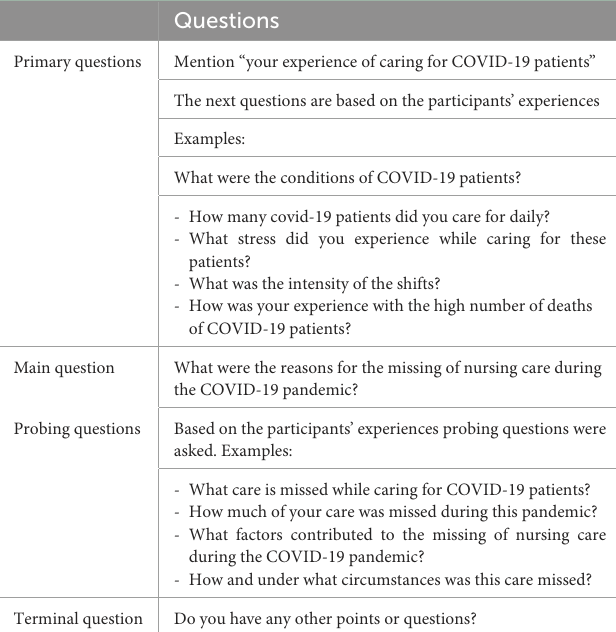
TABLE 2 The interview questions. TABLE 3 Qualitative data analysis process based on Graneheim and Lundman method